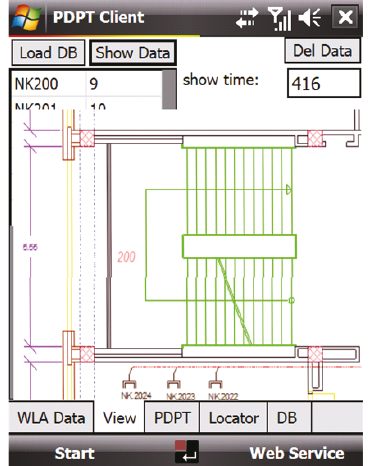
Figure 7: PDPT Client. On PDPT tab is a summary of prebu ff ered artefacts history and a part and full time of prebu ff ering. The upper part of screen is only for testing the functionality.